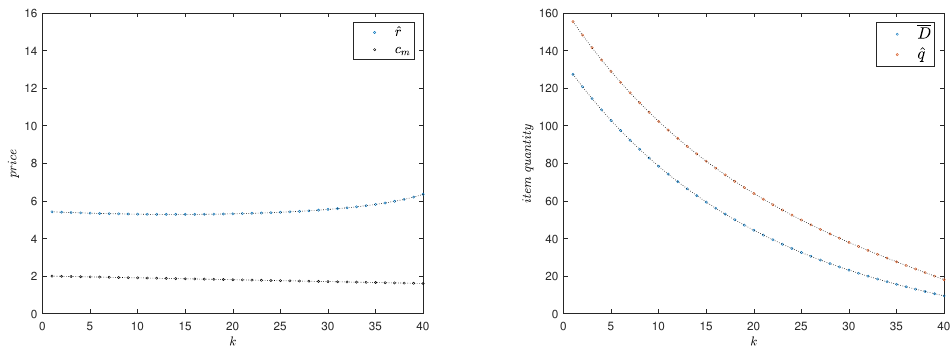
Figure 3. Pricing and supply quantities at equilibrium states in a centralized